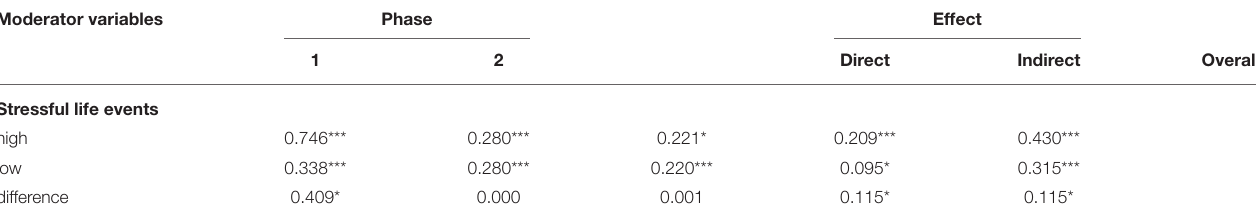
TABLE 3 | Simple effect analysis of moderated mediating effects of stressful life events (X = promotion focus).